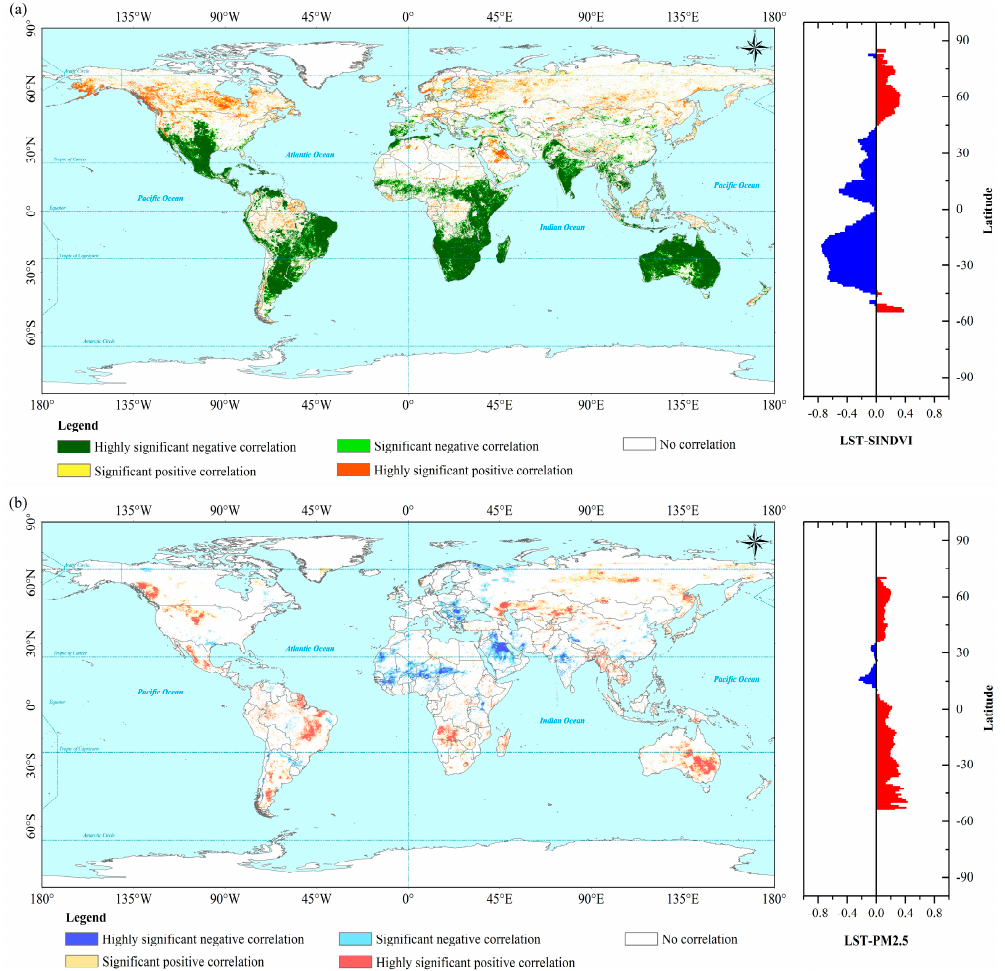
Figure 2. Correlation coefficients (left) between LST and SINDVI ( a ) and LST and PM 2.5 ( b ) at a global scale. These coefficients were divided into highly significant negative correlations ( p < 0.01), significant negative correlations ( p < 0.05), highly significant positive correlations ( p < 0.01), significant positive correlations ( p < 0.05), and no correlations ( p > 0.05) according to the degree of significance. The average correlation coefficients among SINDVI ( a ), PM 2.5 ( b ) and LST for latitudinal bins of 1 ◦ were shown on the right.